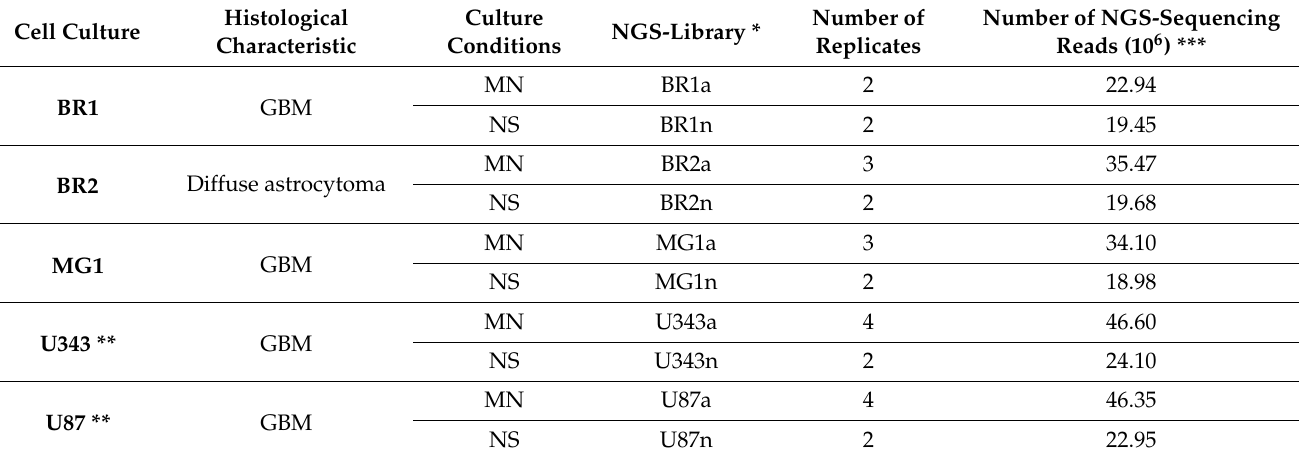
Table 1. Characteristics of human brain tumor cell cultures and RNA sequencing